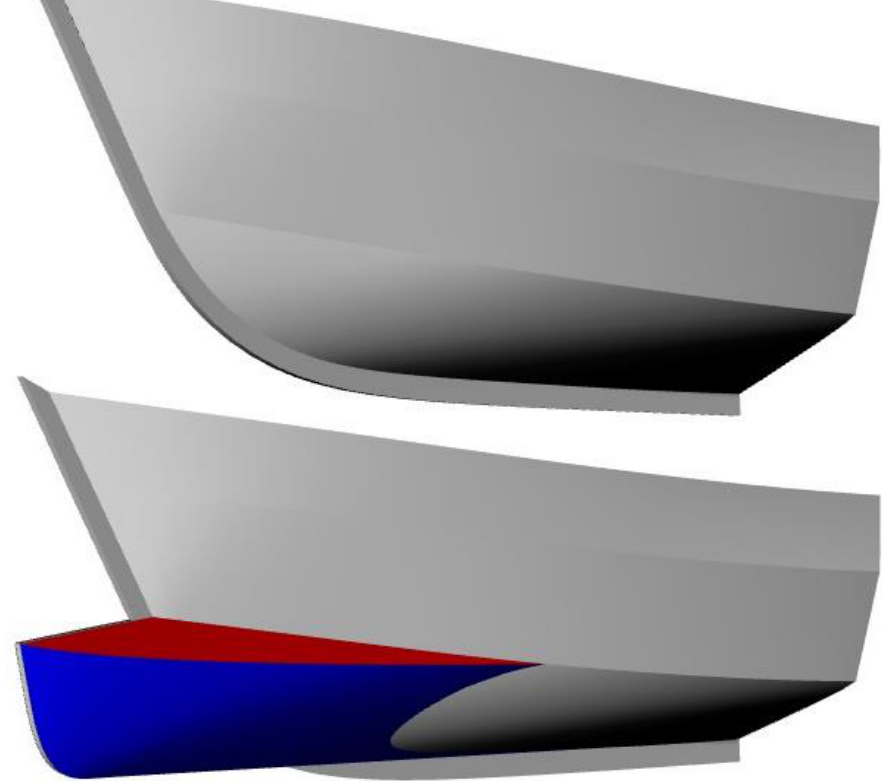
Figure 3. Geometric definition of a polyhedral Bulbous Bow.